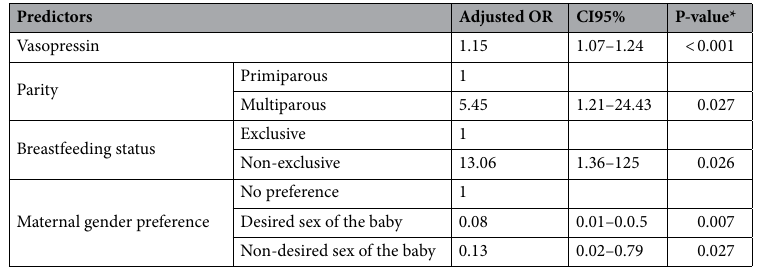
Table 2. Logistic regression analysis of factors affecting postpartum depression. R2 = 0.41. *P values are adjusted for education level, history of abortion, baby gender, mode of delivery, and living